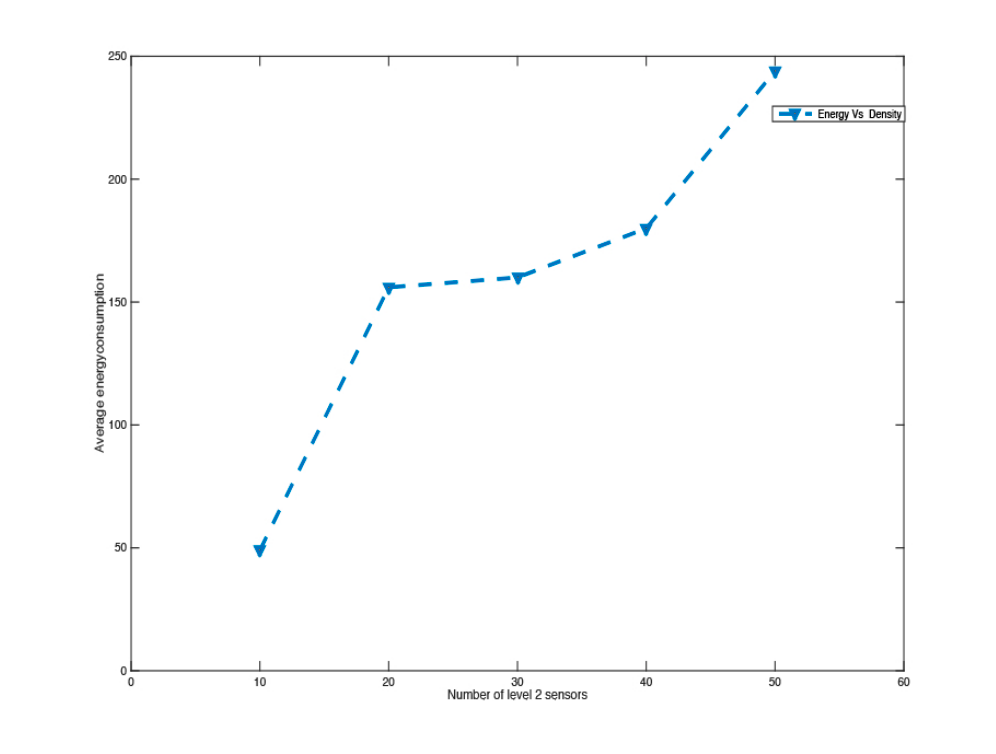
Figure 17. Energy consumption of level 2 sensors according to their number in the